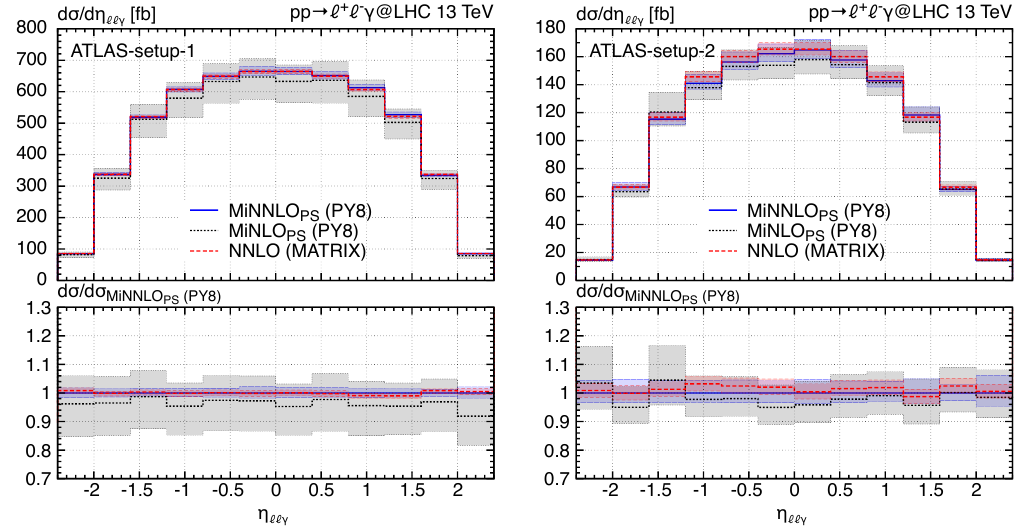
Figure 6. Distribution in the pseudorapidity of the Zγ system in ATLAS-setup-1 (left plot) and in ATLAS-setup-2 (right plot) for MiNNLO NNLO (red, dashed line).